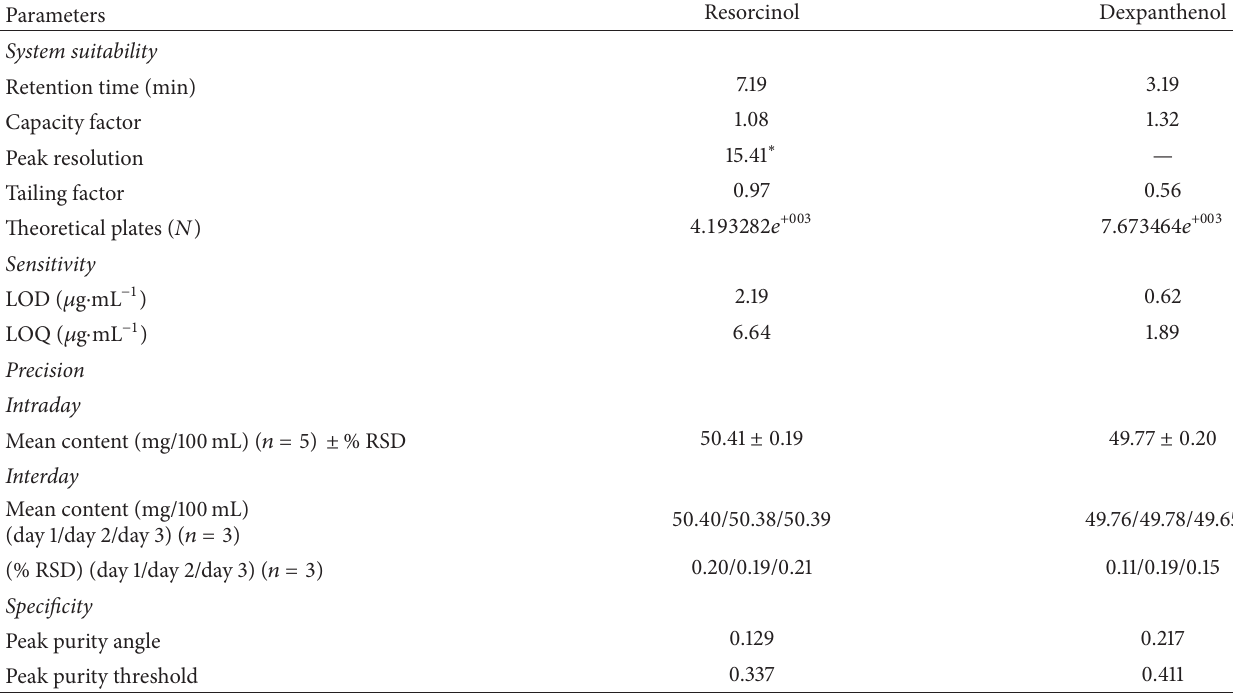
Table 3: System suitability and method validation data for the simultaneous quantification of DP and